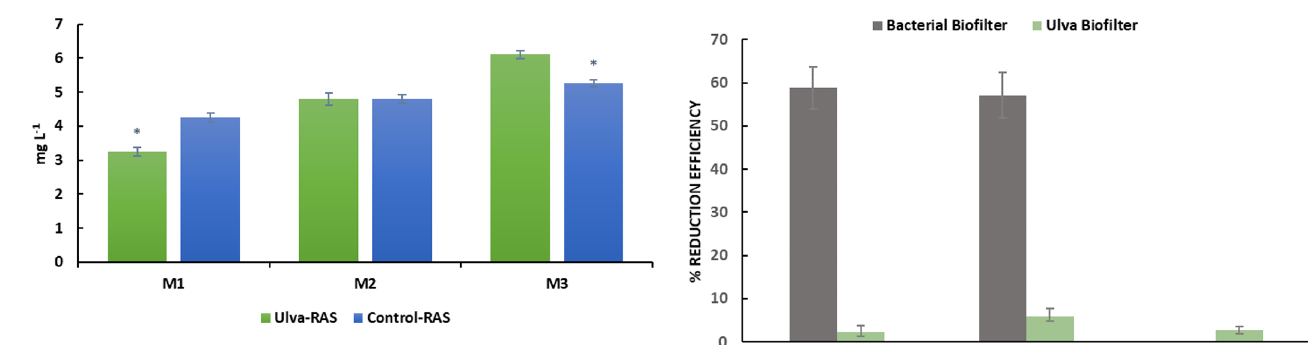
Fig. 3. Mean values (±SE) of orthophosphates (PO 3 (cid:1) Ulva -RAS and control-RAS during each month (M) of the experiment. * denotes signi fi cantly statistical differences between the two systems for the same month.